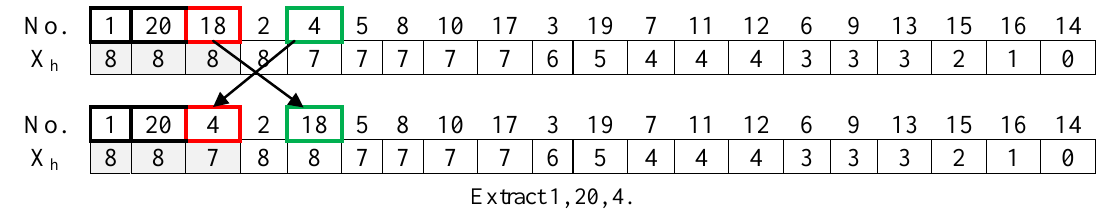
Figure 6. Example of a conflict process of a teacher’s